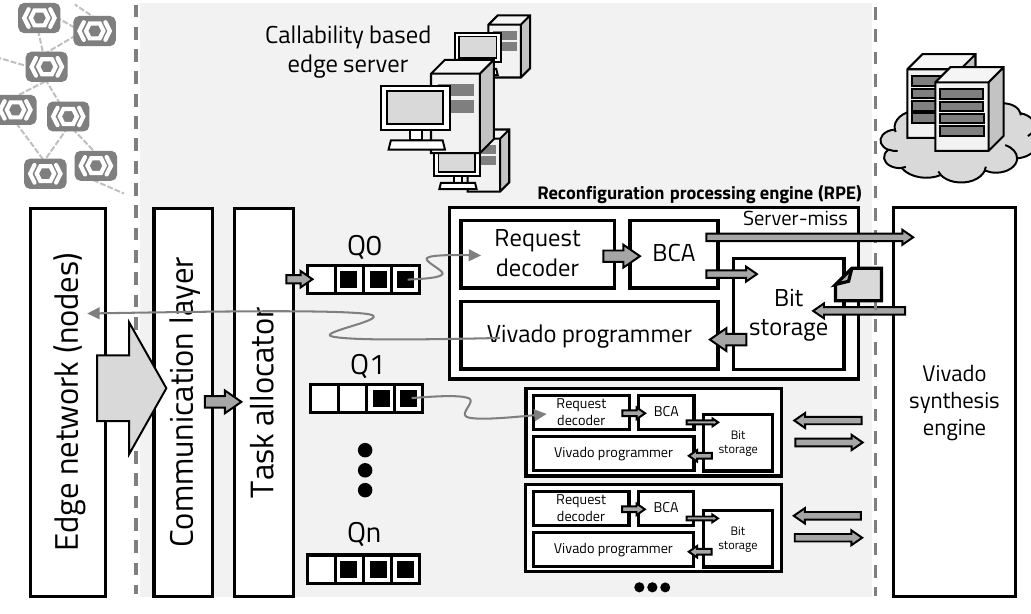
Figure 7. mIoT server